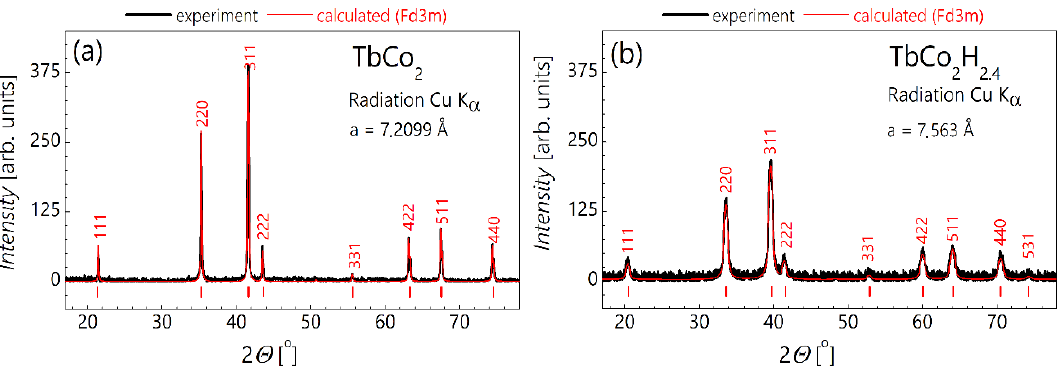
Figure 1. X-ray diffraction patterns for TbCo 2 ( a ) and its hydride TbCo 2 H 2.4 ( b